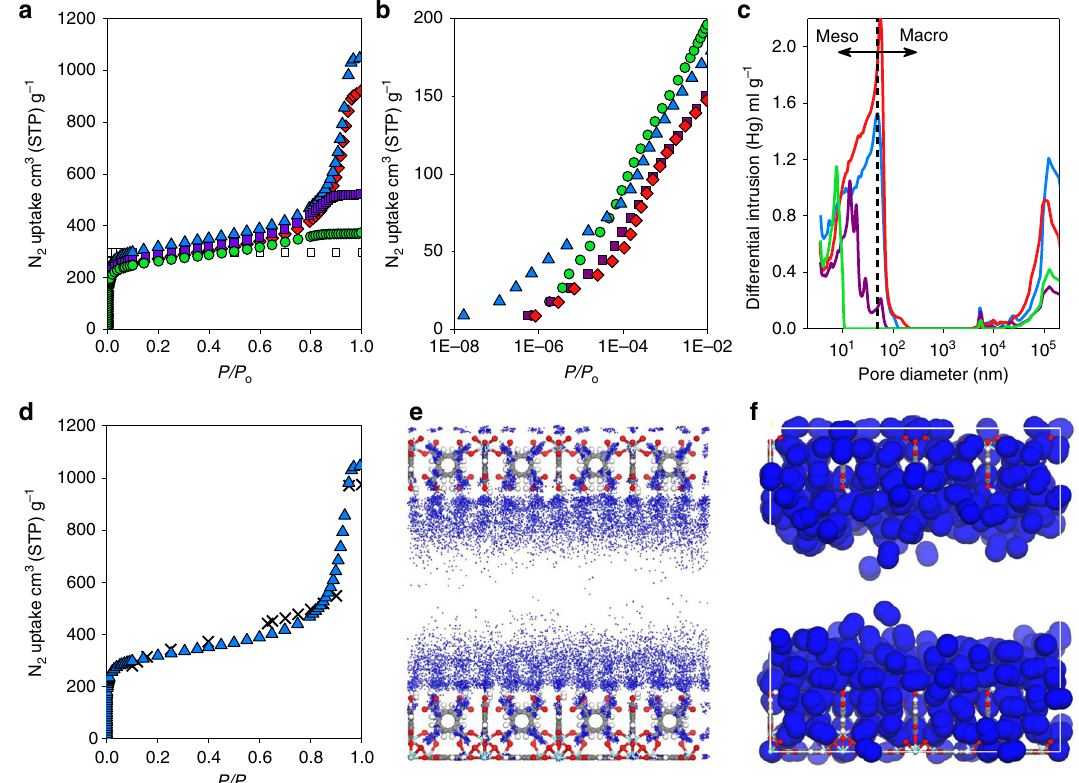
Fig. 4 N 2 adsorption isotherms and Hg-porosimetry pore-size distributions of UiO-66 monoliths. a Linear and b , semi-log isotherm plots of gravimetric N 2 uptake at 77 K for monolithic UiO-66_A (blue triangles), UiO-66_B (red diamonds), UiO-66_C (purple squares) and UiO-66_D (green circles). The theoretical isotherm (white squares) was simulated from the crystal structure of UiO-66 (Supplementary Fig. 15). The experimental isotherms indicate extensive microporosity, which is comparable with the simulated isotherm, as well as variable mesoporosity, indicated by N 2 uptake at higher relative pressure. c Pore-size distributions (PSD) obtained by Hg-porosimetry showing the variations in meso- (2 – 50 nm diameter) and macro- (> 50 nm diameter) porosity amongst the materials. d Comparison of experimental mono UiO-66_A (blue triangle) and simulated micro-/mesoporous UiO-66 (black cross), indicating the good match obtained when using an appropriate ratio of porosities (see the Methods section). e , f The density distribution and a snapshot, respectively, of simulated N 2 adsorption (navy blue spheres) at 0.7 P/P o (i.e., before capillary condensation — the micropores and the mesopore walls are completely fi lled by N 2 , whereas the centre of the mesopore remains empty) between two UiO-66 crystals (Zr; blue, O; red, C; grey and H; white) separated by a 2.3 nm mesopore (representative of mono UiO-66_D)